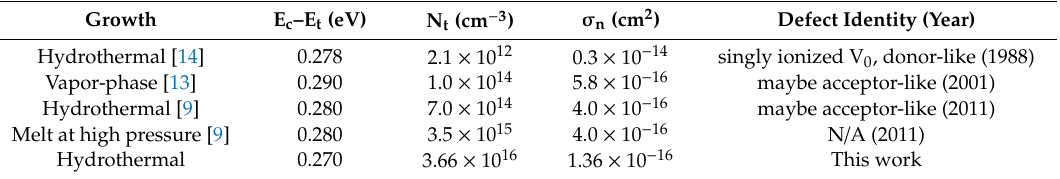
Table 1. Literature survey of the electronic properties of prominent defects investigated by deep level transient spectroscopy (DLTS) in as-grown ZnO; the defect energy level ( E t ), defect concentration ( N t ), capture cross section ( σ n ) and oxygen vacancy ( V 0 ).